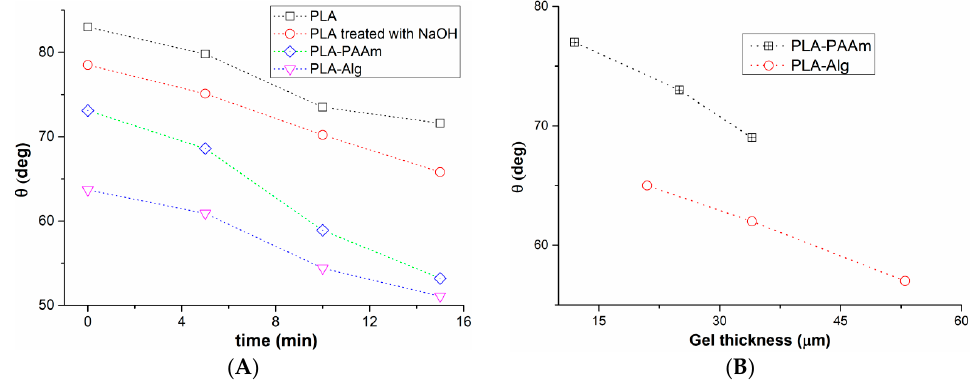
Figure 6. Dependences of the contact angle values measured on the modified films: ( A ) on time; ( B ) on gel thickness.